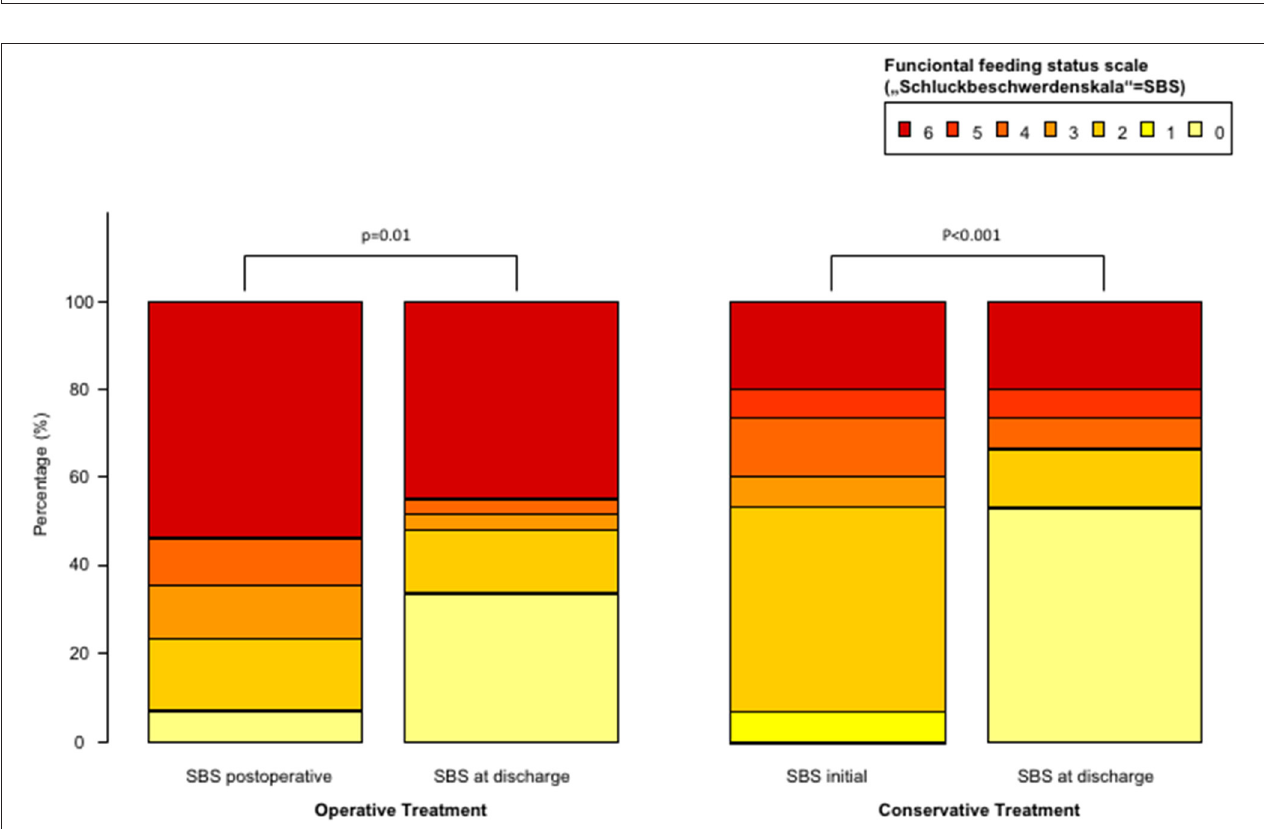
FIGURE 3 | Functional feeding status scale in patients with dysphagia divided by operative and conservative treatment of subdural hematoma.